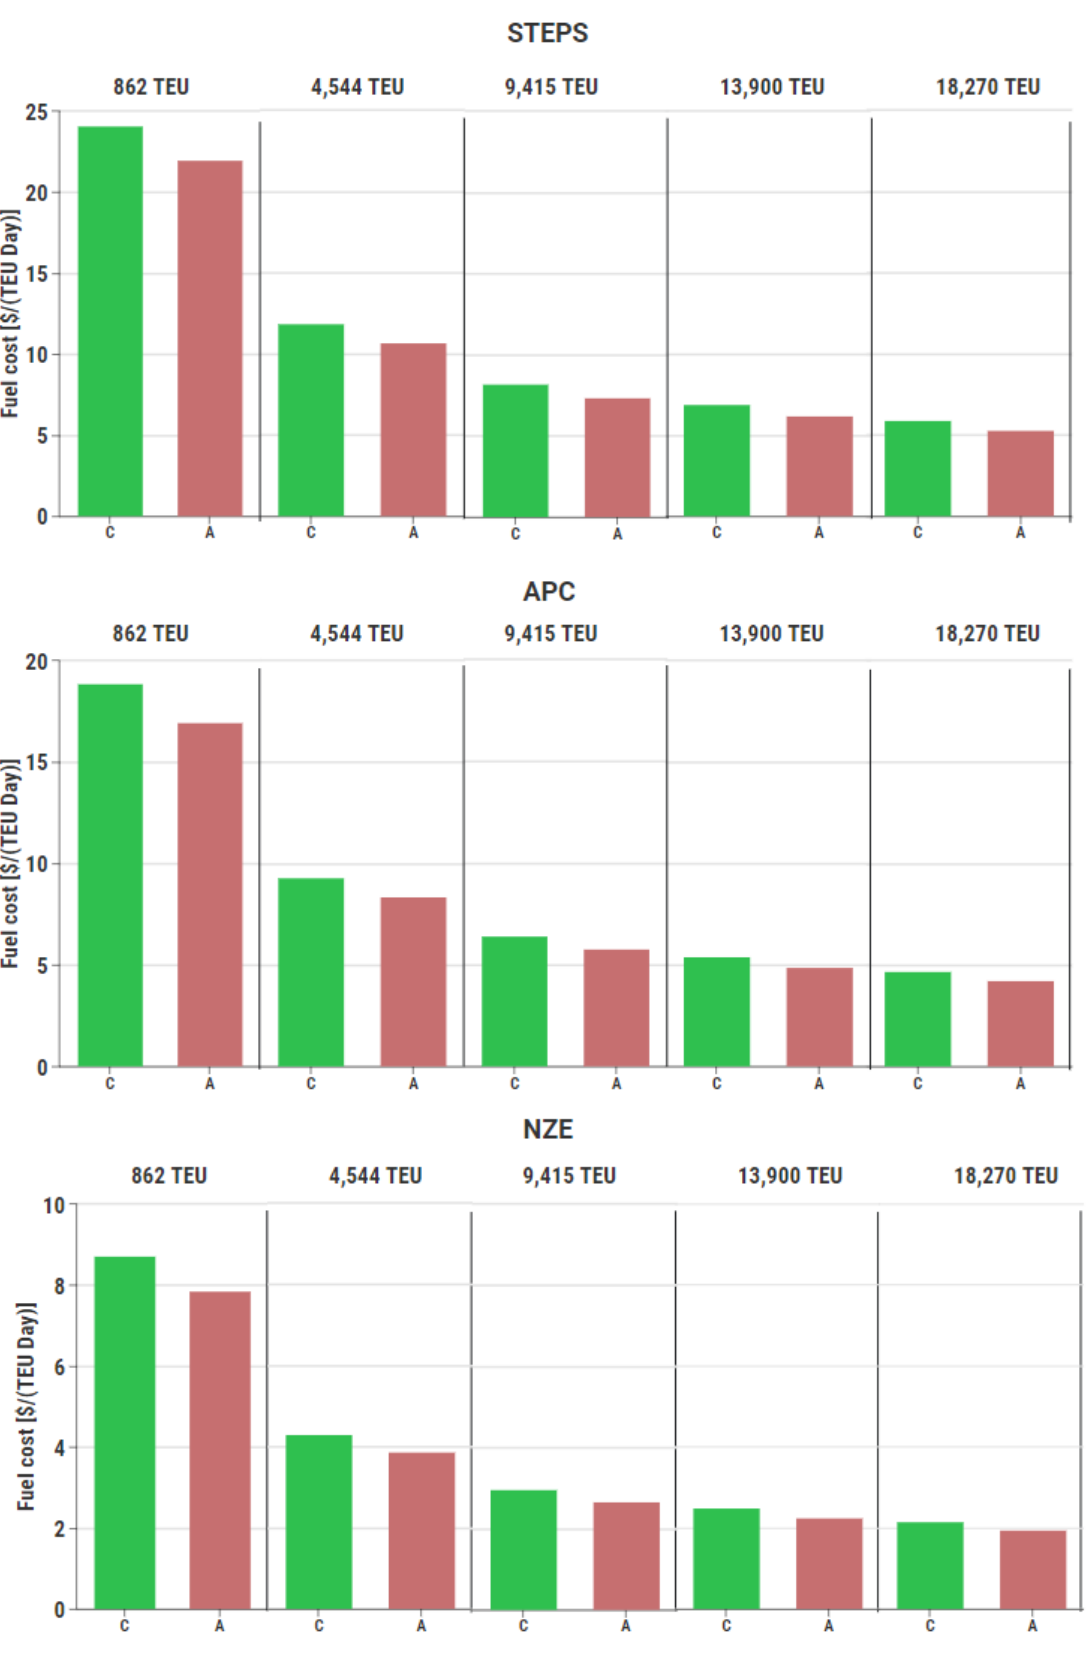
Figure 8. Daily fuel costs per container for STEPS, APC, and NZE scenarios for the year 2040. Daily emission and fuel costs are calculated for the representative year of 2040. Daily emission and fuel costs, calculated for all five conventional and autonomous ships for STEPS, APC, and NZE scenarios, indicate that economies of scale occur with an increase in ship capacity. That means that overall daily costs per unit decrease with an increase in ship capacity. Autonomous ships have lower daily costs for all ships and scenarios.